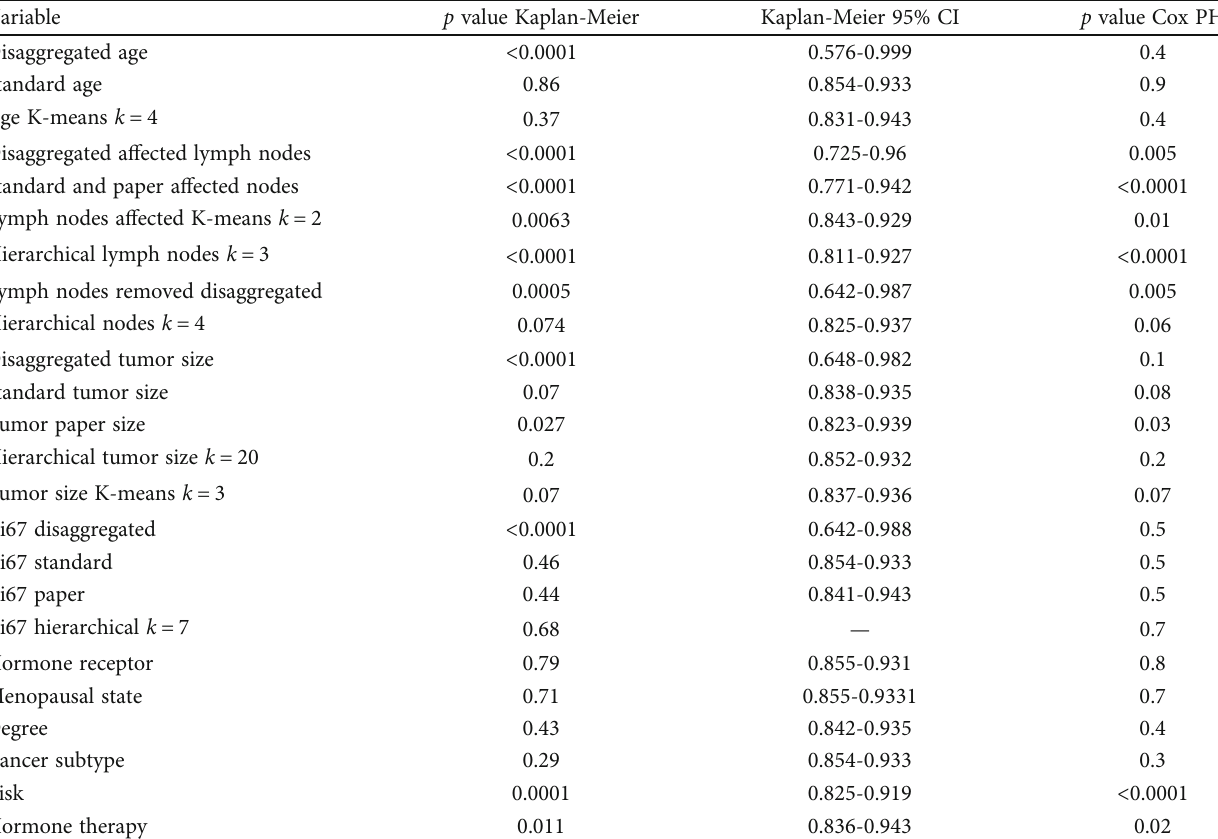
Table 3: Hospital variable quality analysis from p value and 95% CI.